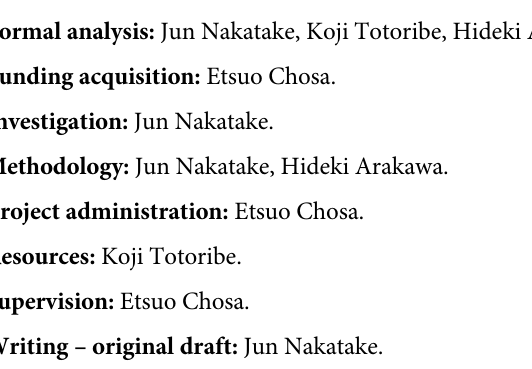
S4 Table. Effect size of differences in mean angles among the four eating phases. S5 Table. Individual values of ranges of motion in each phase of eating. S6 Table. Effect size of differences in ranges of motion among the four eating phases. S7 Table. Time-normalized integrated values of joint angles for each phase of